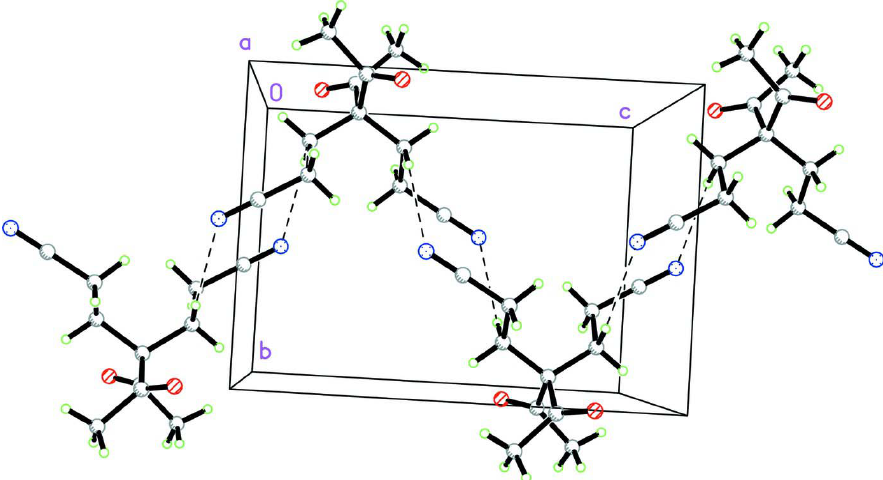
Figure 2 The crystal packing of (I), viewed down the a axis. Hydrogen bonds are drawn as dashed